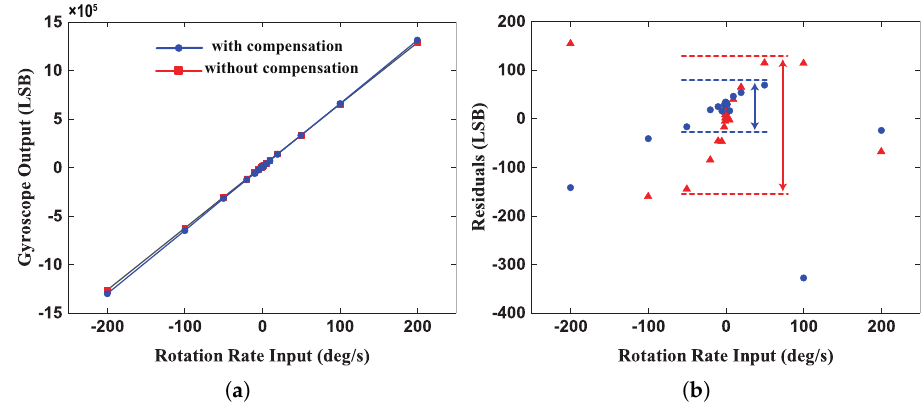
Figure 15. ( a ) Raw and compensated output of the gyroscope within ± 200 ◦ /s. ( b ) The residual error of the scale factor in both